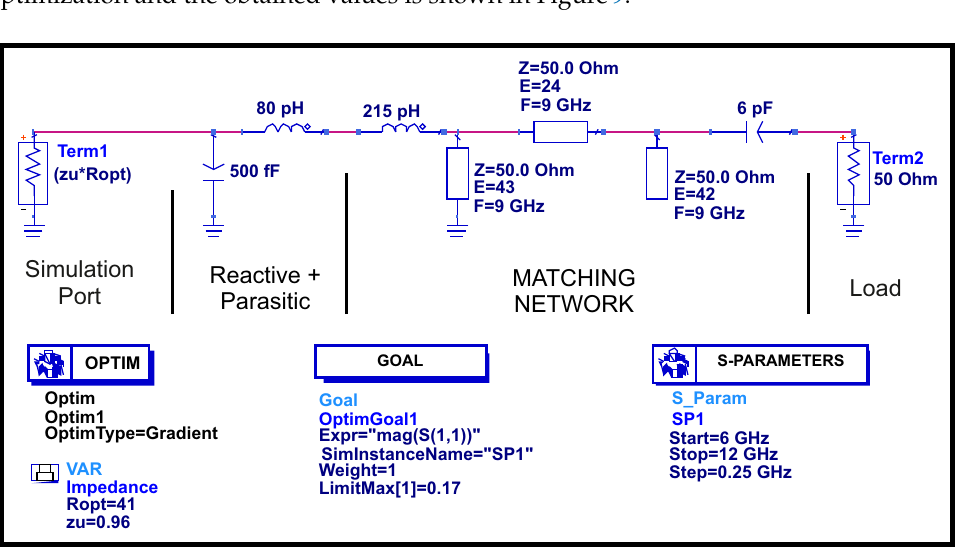
Figure 9. Linear simulator for the optimization of the matching network targeting the 0.5dB effi- ciency contours.